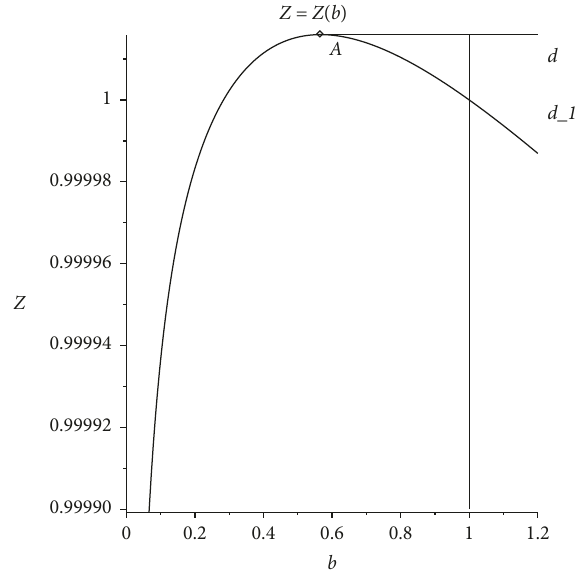
Figure 4: Plot of 𝑍 = 𝑌/𝑌 0 and 𝑏(𝑡) = 𝑎(𝑡)/𝑎 0 : 𝑏 = 1 is current age of the universe. After reaching the point A, the function Y (t) branches. It may evolve on the straight line 𝑑 or the curve 𝑑 1 .